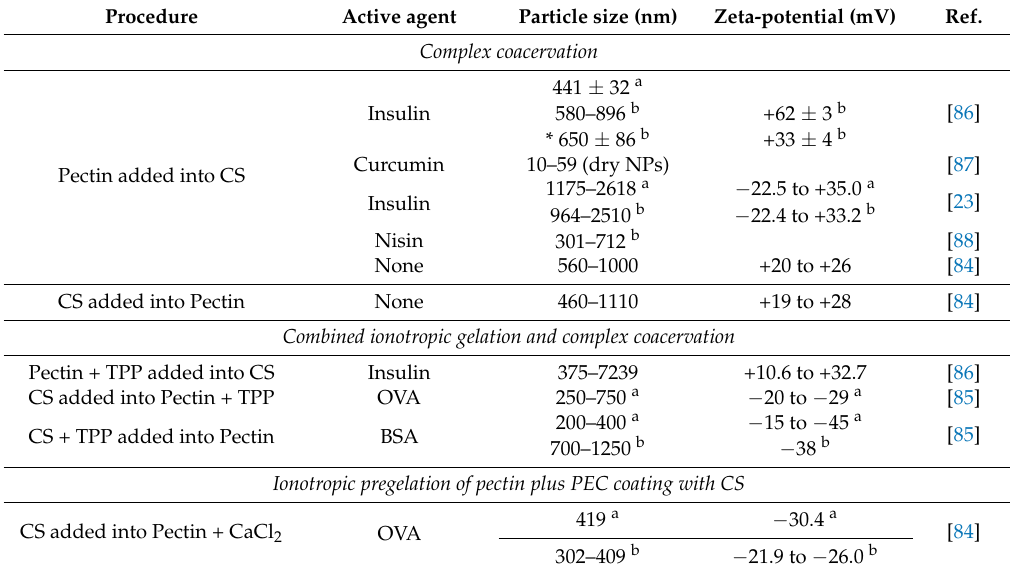
Table 2. Chitosan-Pectin PEC nanoparticles. The intervals shown generally indicate extreme values obtained under different preparation conditions.